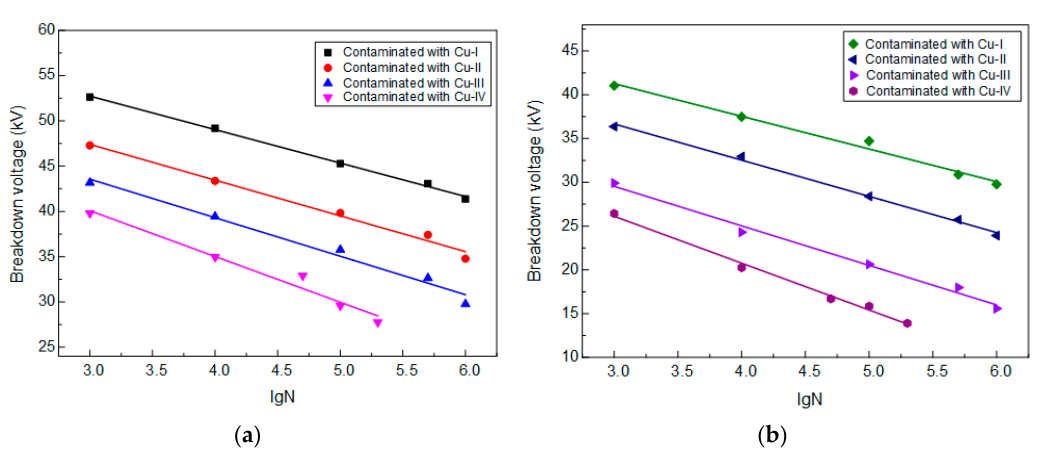
Figure 3. AC breakdown voltage of ( a ) vegetable insulating oil and ( b ) mineral insulating oil contaminated with copper particles. Table 2. Influence of copper particles on AC breakdown voltage of vegetable insulating oil. Particle Size ( μ m)